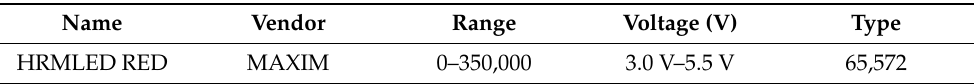
Table 8. Sensor specifications for the smartphones used in this experiment.